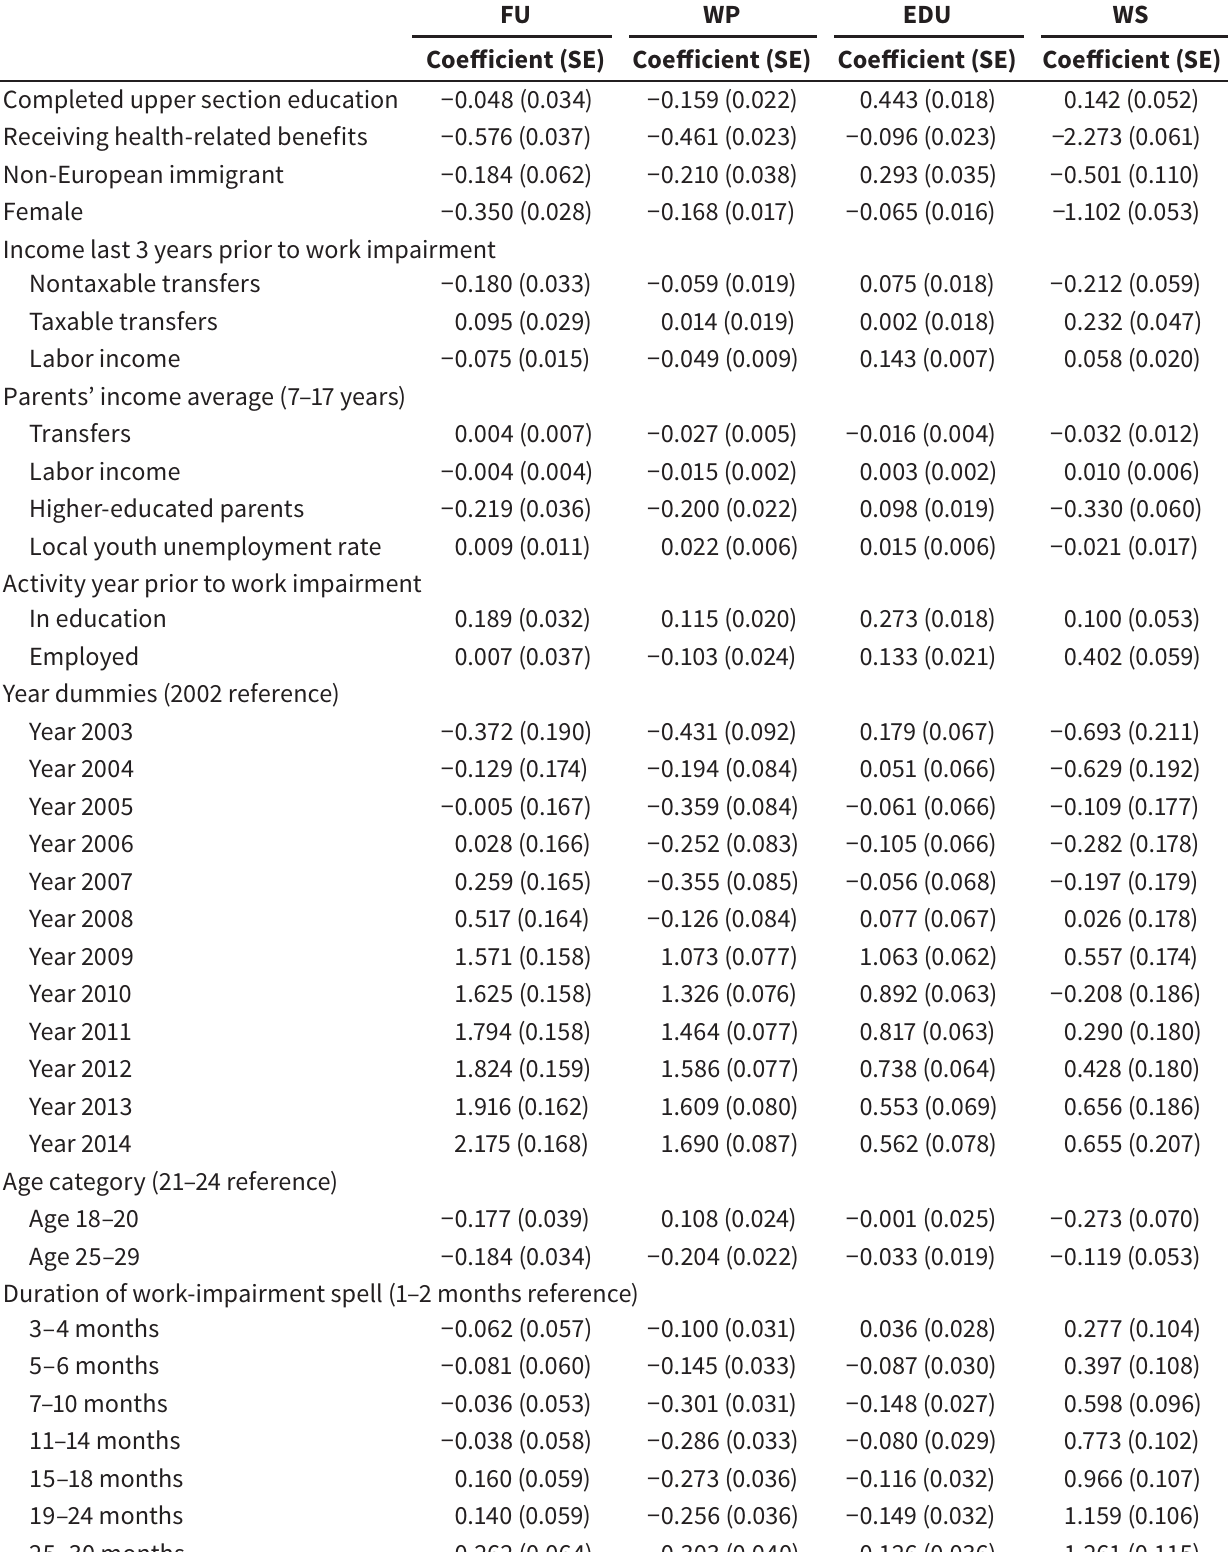
Complete estimation results: Transitions to vocational rehabilitation programs